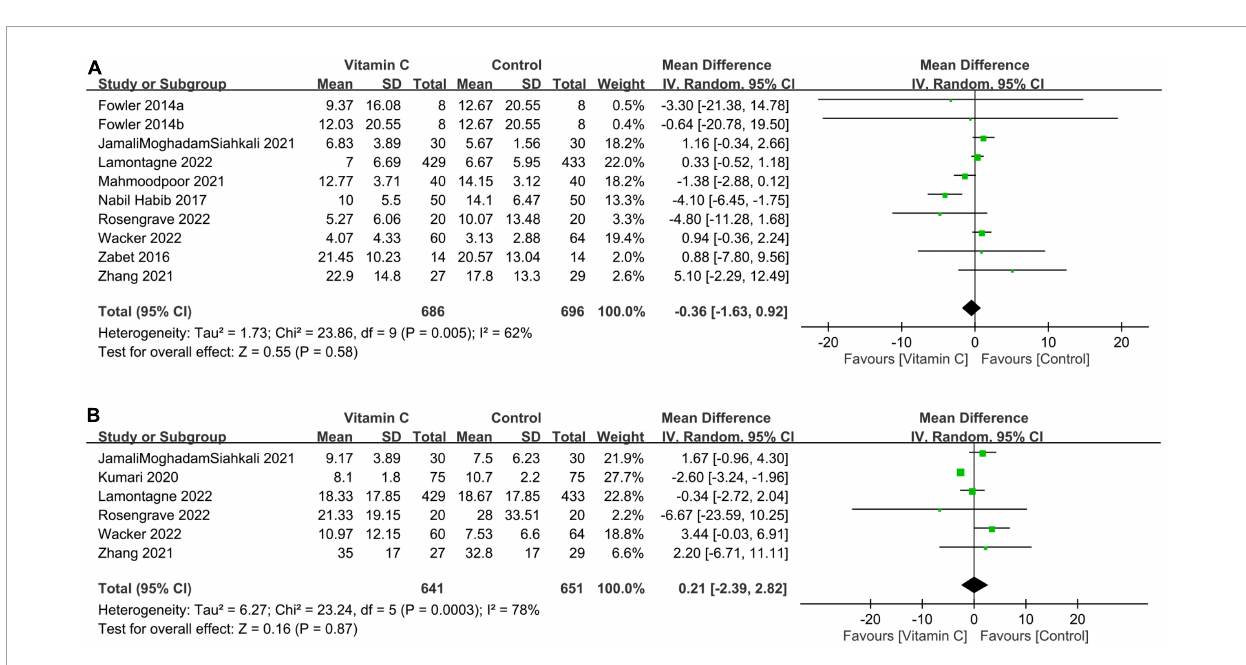
FIGURE8 Forest plot comparing the (A) length of stay in the intensive care unit (ICU) and (B) length of hospital stay between the intravenous vitamin C and control groups. M-H, Mantel-Haenszel; CI, confidence interval.